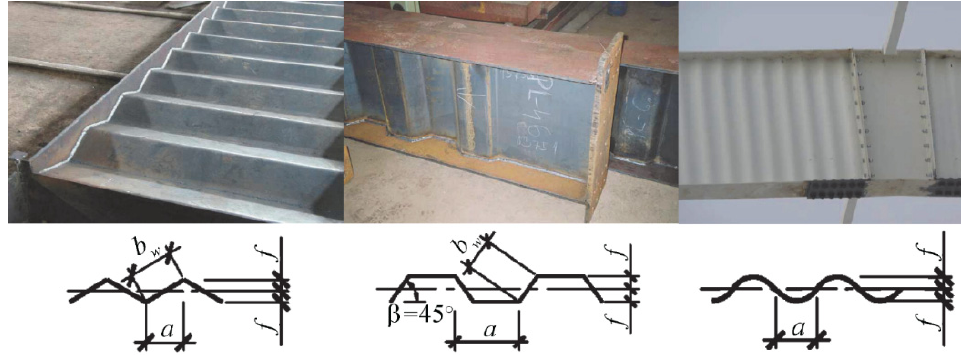
Figure 2. Plate girders with folds perpendicular to the longitudinal axis of the plate girder [2].